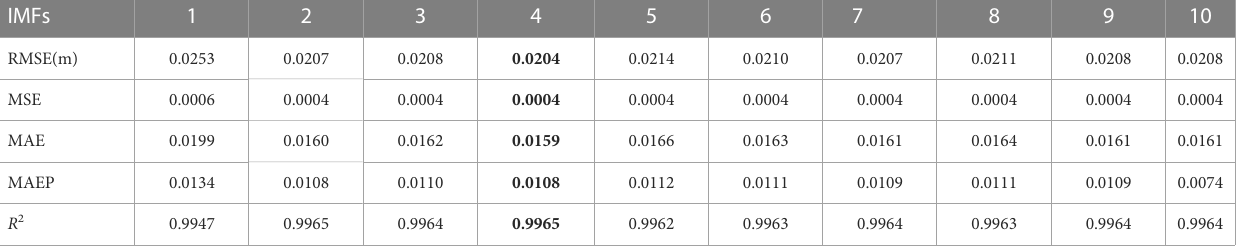
TABLE 1 Prediction results of EEMD-LSTM model for SWH in the next 1 hour for different values of timestep. Timestep